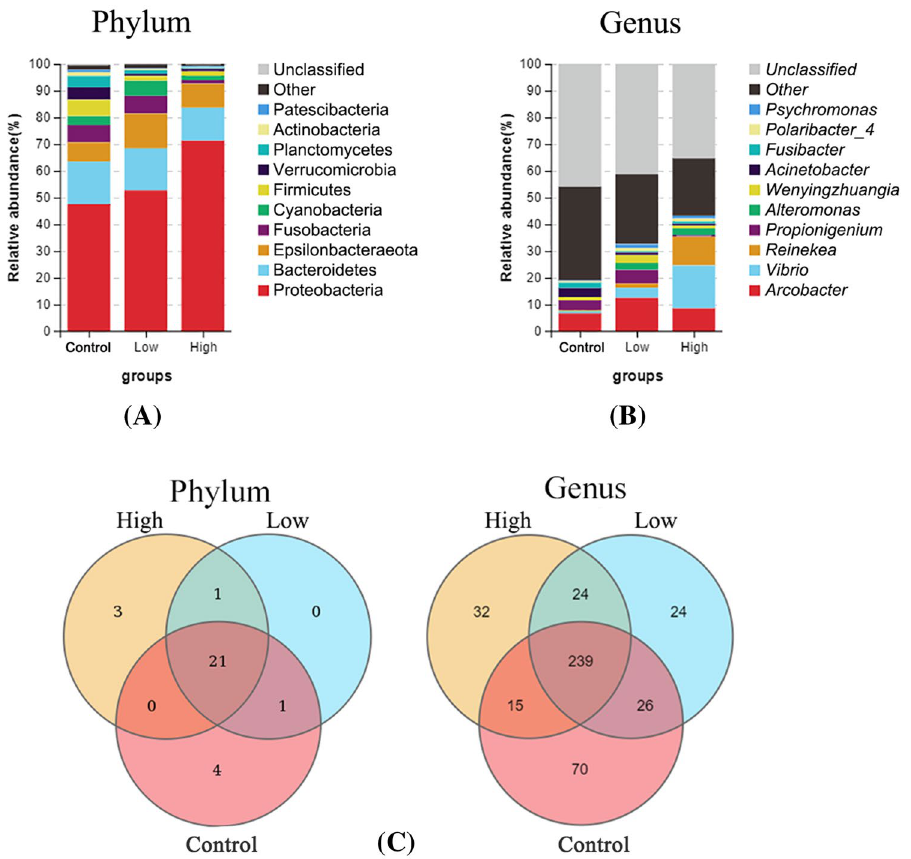
Figure 2. Effects of increased UV-B radiation on the top 10 phyla ( A ) and top 10 genera ( B ) of the epiphytic bacteria of S. thunbergii and the top 10 phyla; ( C ) Indicator species ( P < 0.05) at the phylum level under increased UV-B